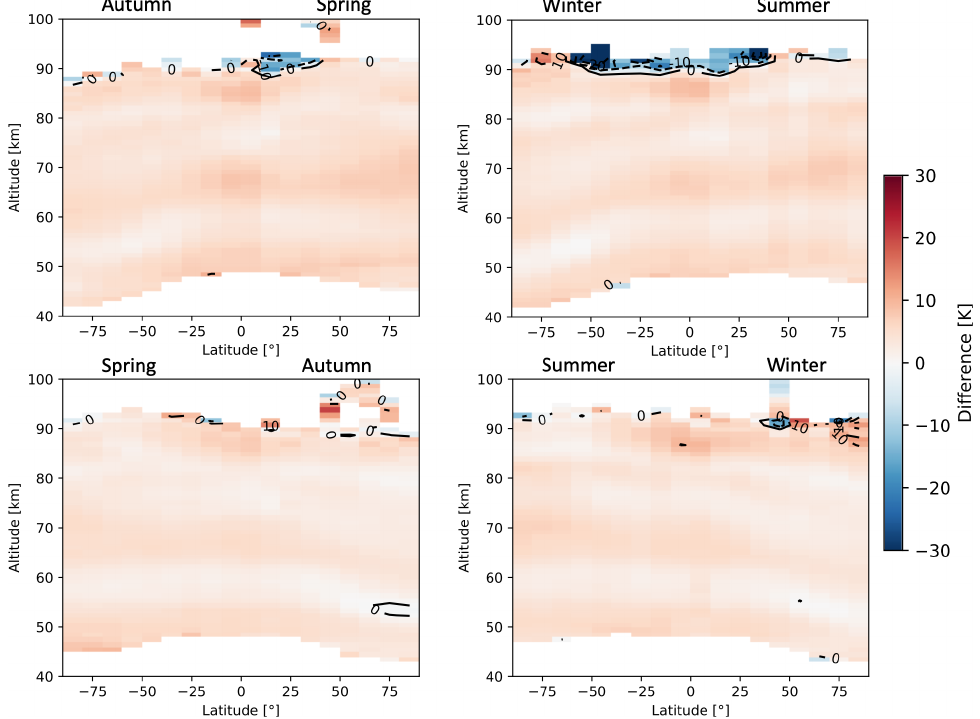
Figure A9. Seasonal zonal means of temperature FM19 SMR v3.0–v2.1 relative differences averaged over the whole time period between February 2001 and April 2019. The seasons are intended as astronomical seasons, i.e. each starting at the respective solstice or equinox.